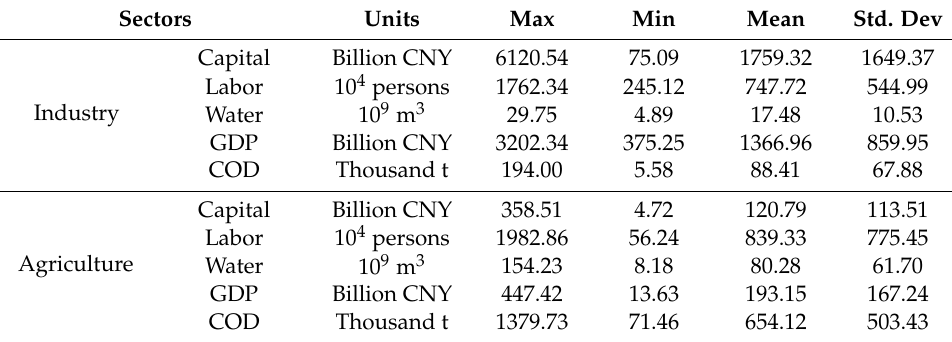
Table 1. Summary statistics of inputs and outputs for industry and agriculture,